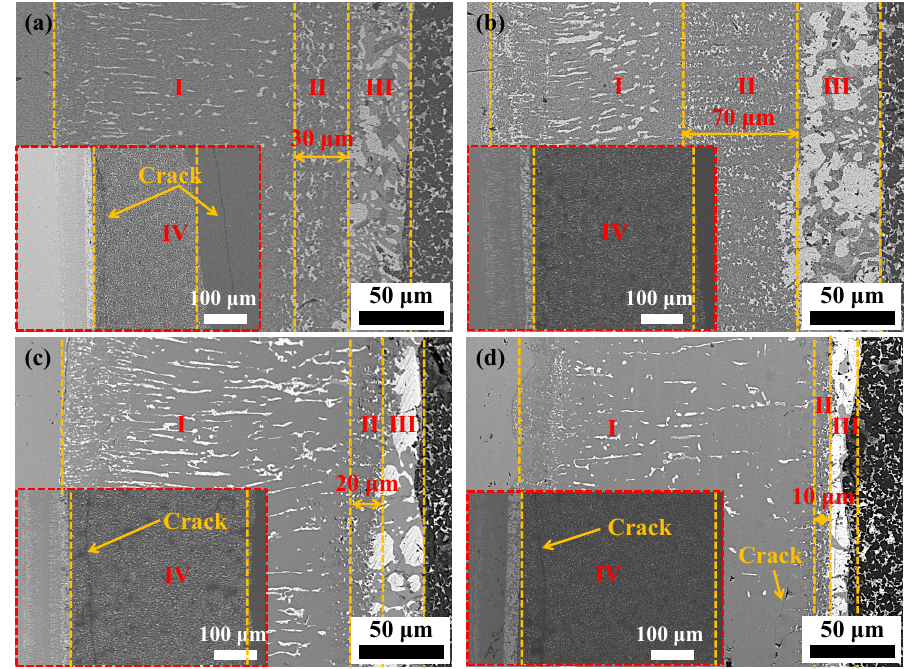
Figure 7. Microstructure of PS-SiC-stainless steel joints brazed for different holding times at 890 °C: